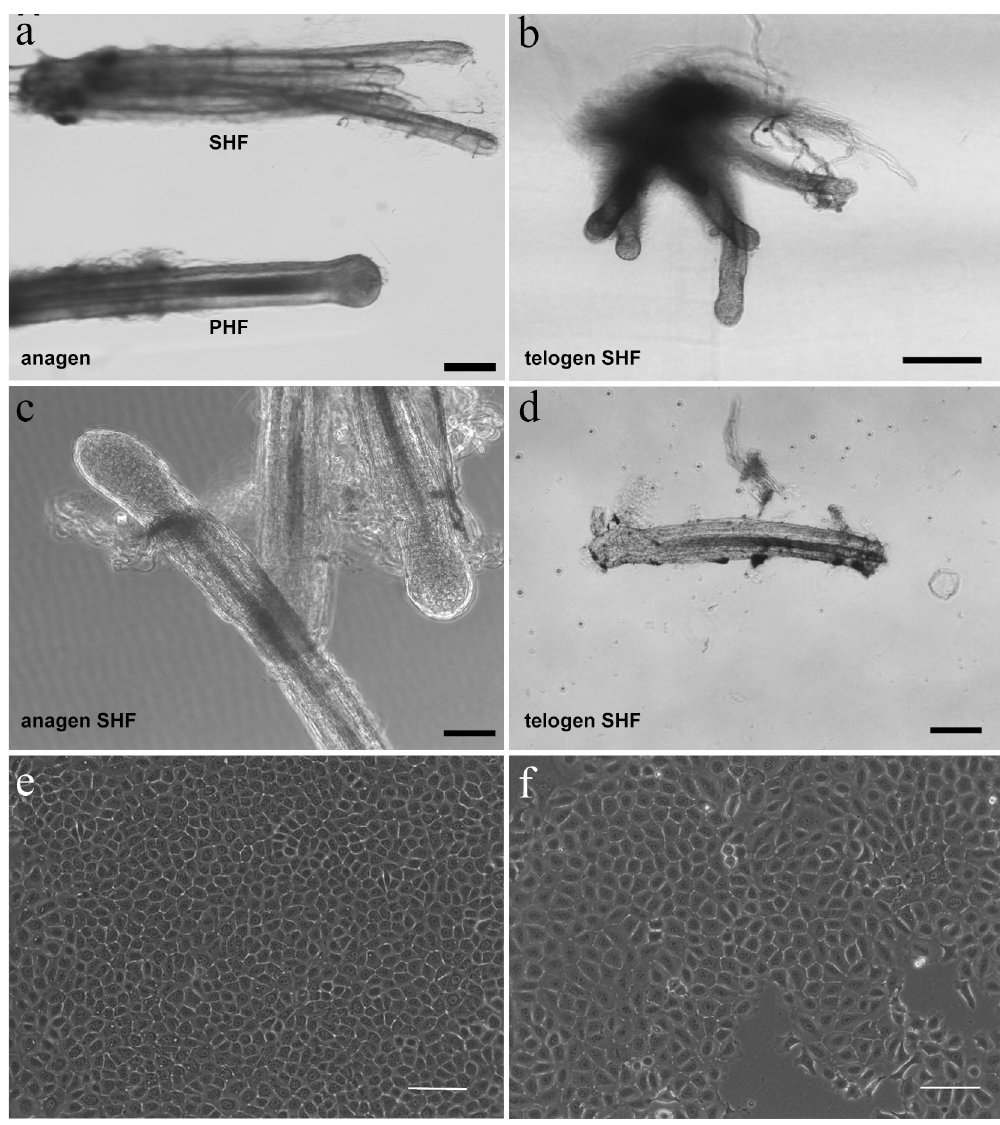
Fig 1. Culture of Inner Mongolia Cashmere goat secondary HFSCs. (a): Inner Mongolia cashmere goat primary (PHF) and secondary (SHF) hair follicles. (b, d): telogen phase SHF. (c): SHF from anagen phase. (e): in vitro cultured secondary HFSCs of anagen phase. (f): in vitro cultured secondary HFSCs of telogen phase. Scale bars 100 μ m.